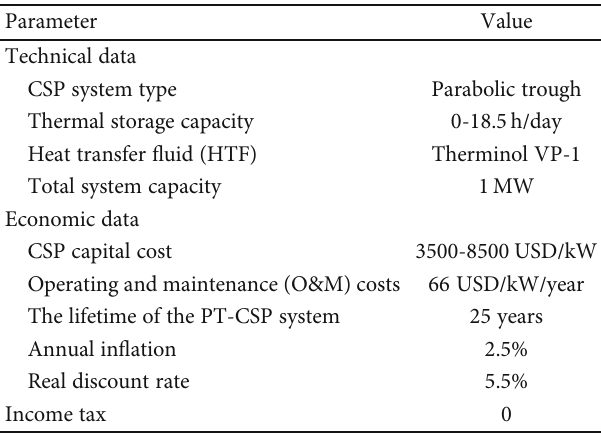
Table 2: Summary of the input data and assumption of the PT-CSP system.